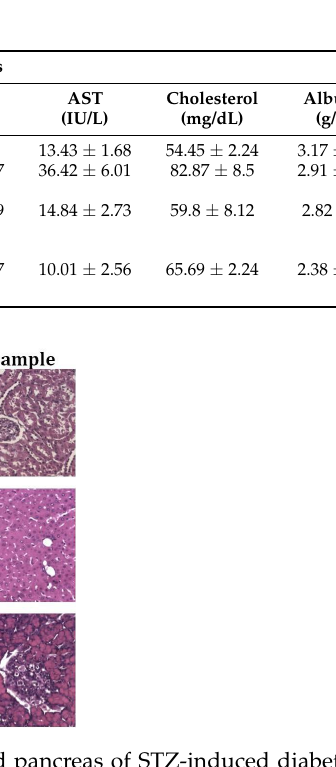
Figure 4. Histopathological changes in kidney, liver, and pancreas of STZ-induced diabetic rats. Photomicrograph (50 μM) of kidney, liver, and pancreas (hematoxylin & eosin) of Diabetic control, Positive control, Normal control, and MEUR. Table 2. Effect of MEUR on levels of various serum parameters of STZ-induced diabetic rats. Each value represents mean ± S.E.M ( n = 6). Serum Parameters Group ( n = 6)